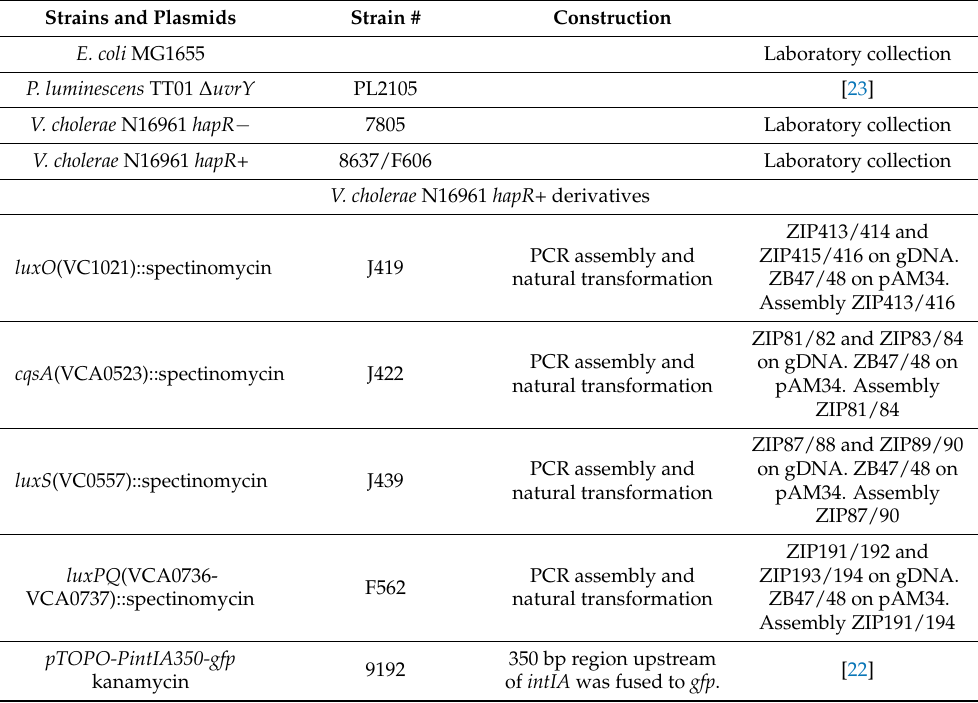
Table 1. Strains and plasmids used in this